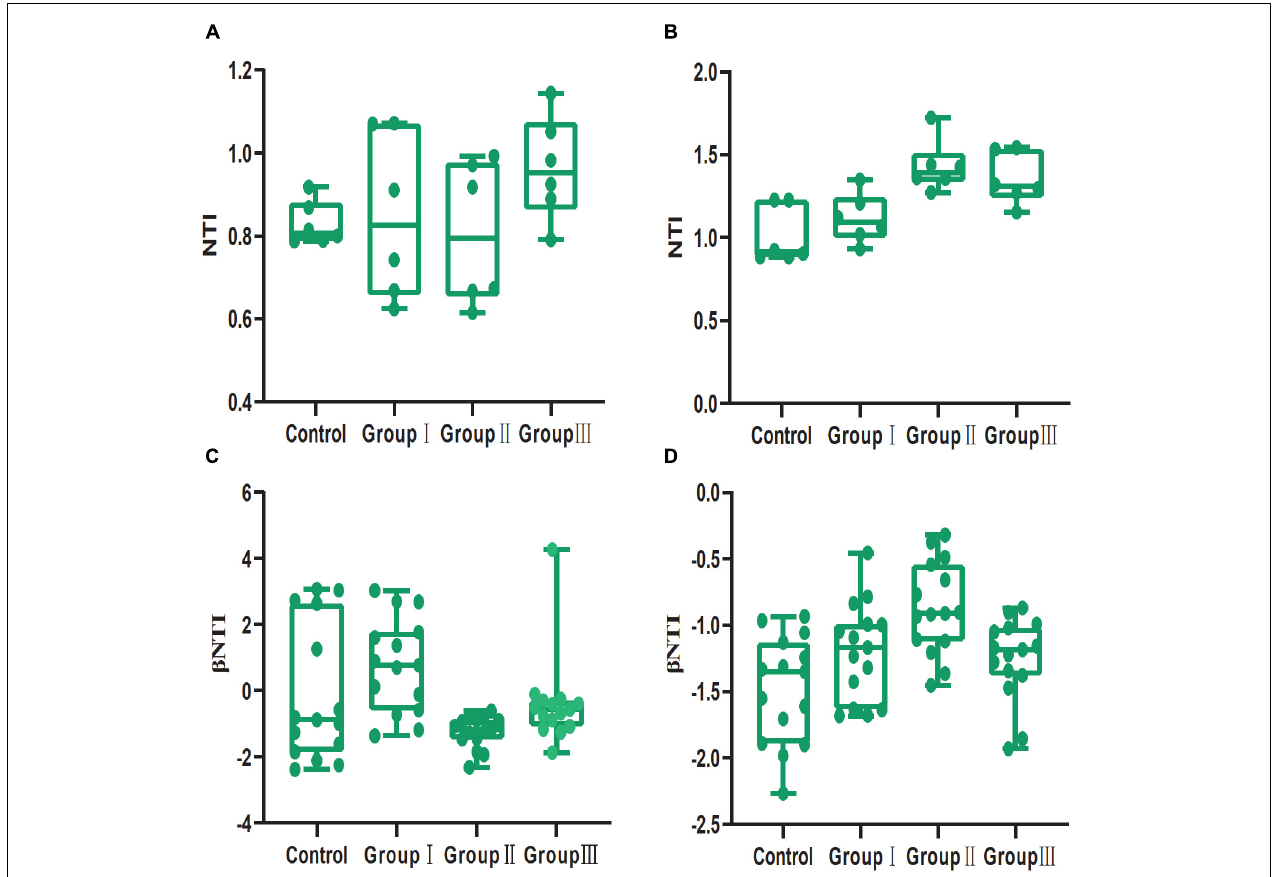
FIGURE 6 | Box plot of NTI and β NTI values of gut bacterial communities from the four dietary fiber groups in jejunal (A,C) and cecal (B,D) contents.